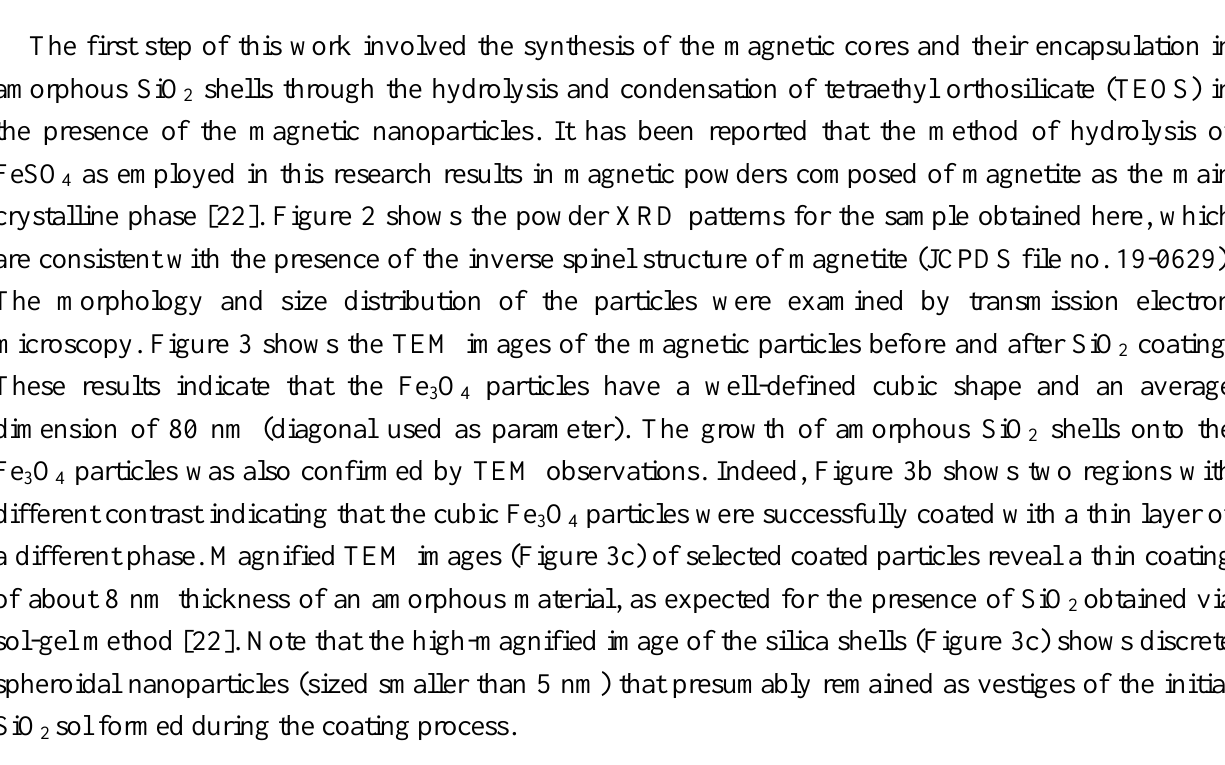
Figure 2. XRD diffraction patterns of the magnetite